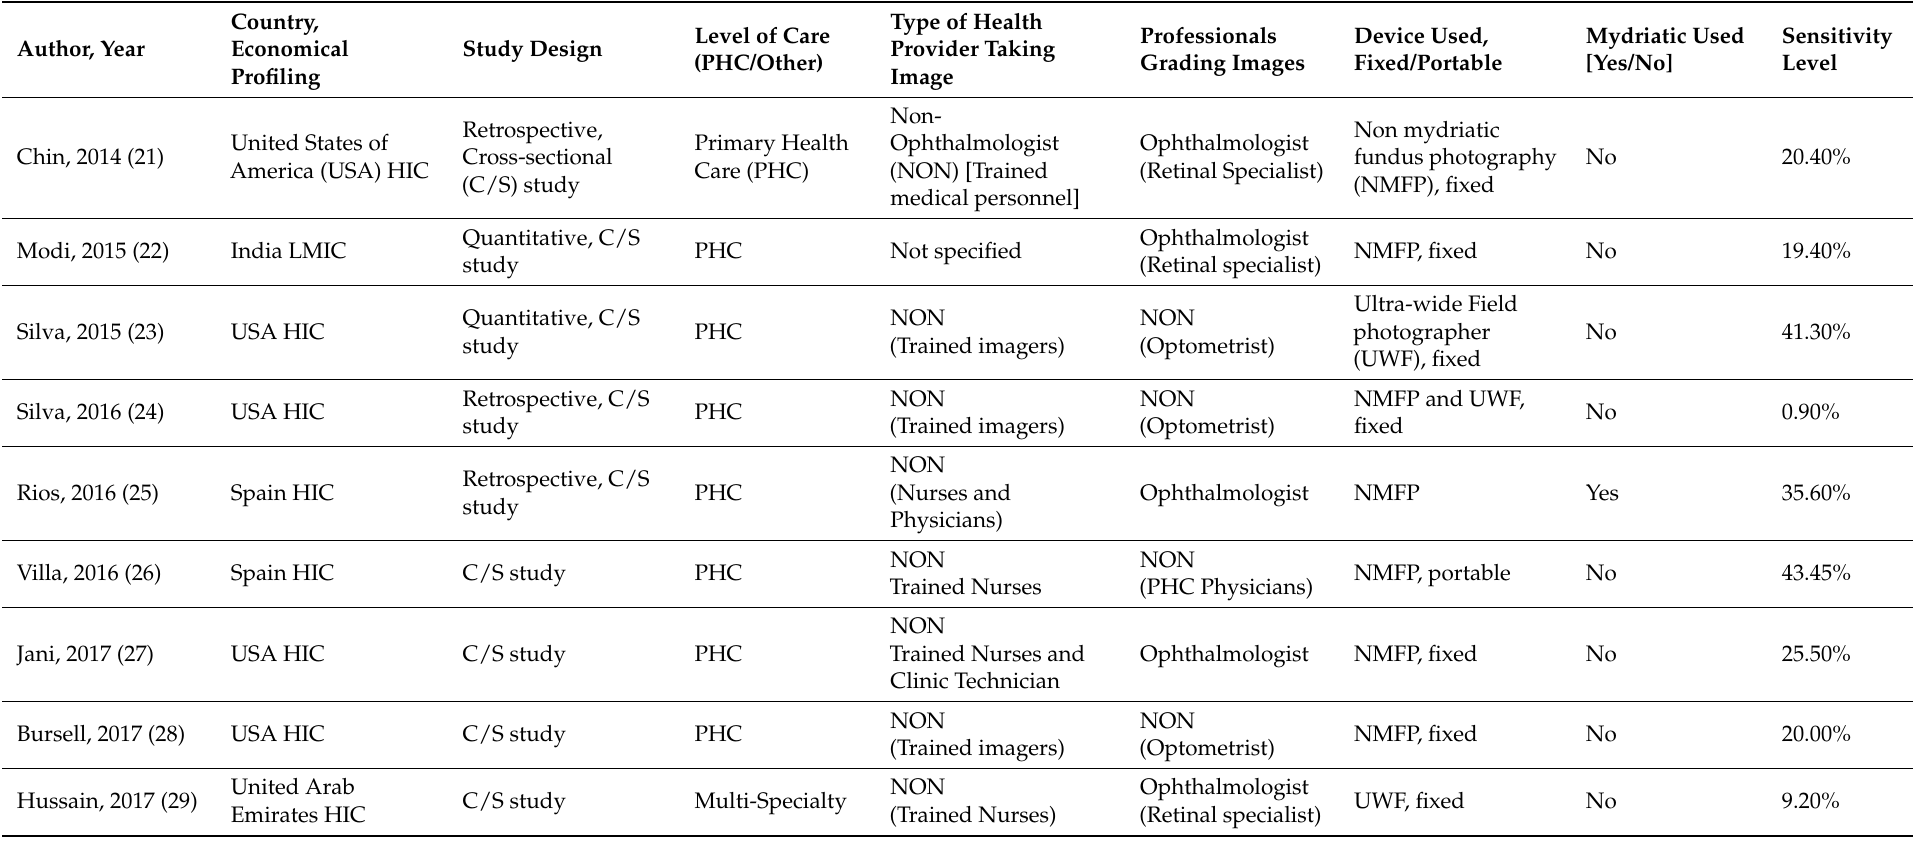
Table 2. Characteristics of nine included studies matching eligibility criteria, presenting evidence on diabetic retinopathy and the use of